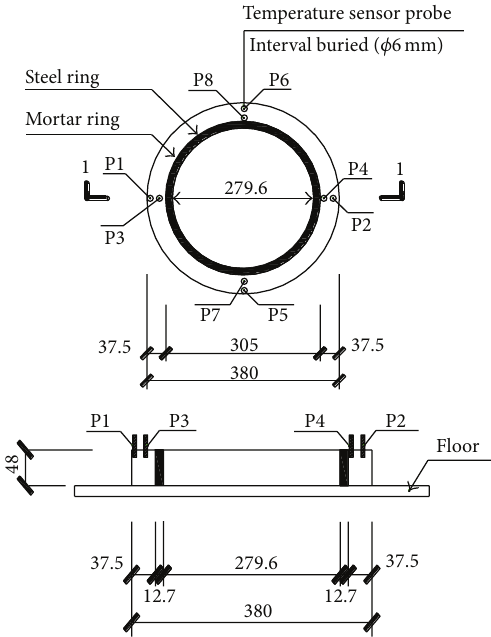
Figure 1: Restrained mortar ring and instruments.